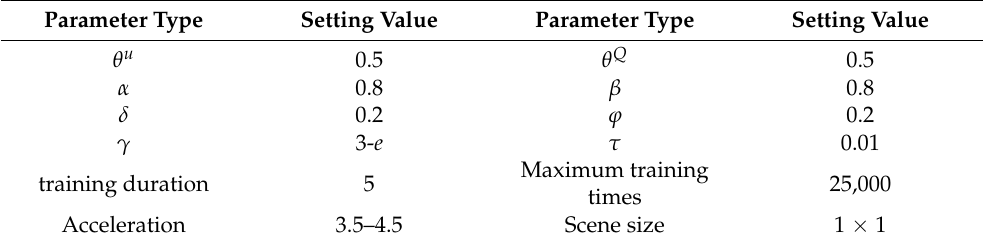
Table 3. Experimental parameter.